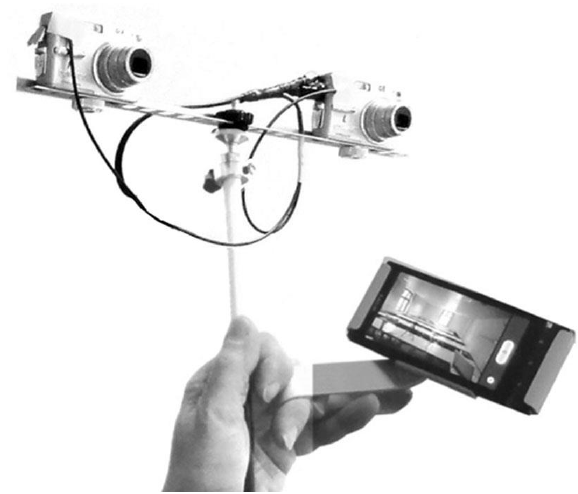
Figure 7. X-Lite carbon telescope staff carrying WLAN capable stereo-cameras with smartphone App based remote control (technical study, partly carried out by St. Kiel